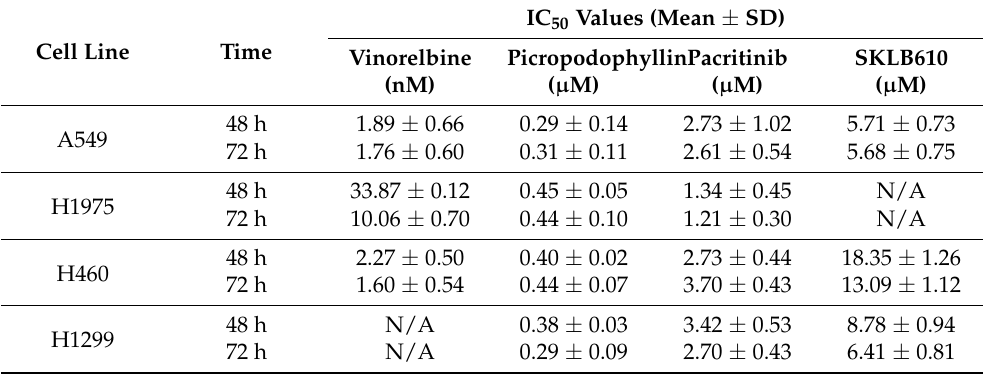
Table 1. The IC 50 values of four anticancer agents in human lung cancer cells. IC 50 Values (Mean ± SD) Cell Line Time Vinorelbine